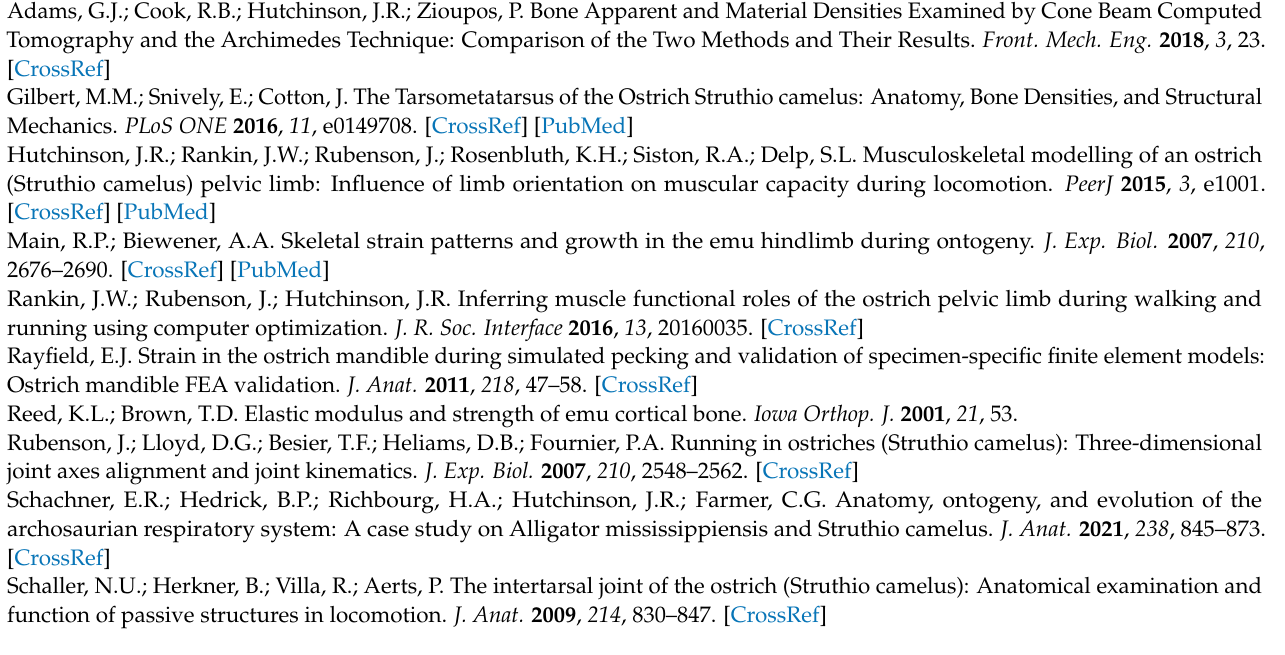
Figure S10: Sample 6.03; Figure S11: Sample 6.04; Figure S12: Sample 6.05; Figure S13: Sample 6.06; Figure S14: Sample